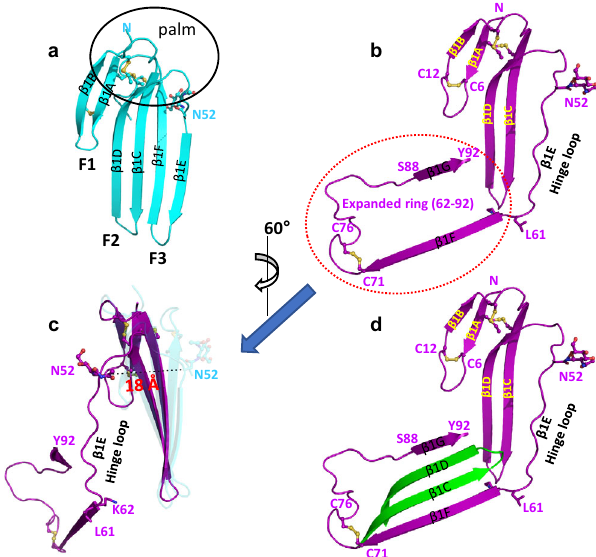
Fig. 3 Major conformational changes of the D1 of dimeric suPAR (this work) compared to the ligand-bound suPAR (PDB 3BT2). a D1 in the ligand-bound suPAR (cyan) forms a typical three- fi ngered fold with a palm region (circled) packed with highly conserved disul fi de bridges. The three fi ngers of this fold are labeled F1-F3. b In dimeric suPAR, the D1 of one protomer (magenta, in an orientation similar to in a ) has only two fi ngers with the β 1F strand of the third fi nger swings away from the D1 pivoting on a hinge (residue 60 – 62, black dashed circle) of D1. The β 1F strand, along with a long loop between the D1 and D2, forms a long expanded ring (residue 62 – 92, circled in the red dashed circle). c A 60°rotation along Y axis of the B orientation shows the β 1E in D1 of dimeric suPAR (magenta) dislodges away, in parallel, from the fi rst and the second fi ngers, leading to a shift of 18 Å, compared to the D1 of ligand-bound suPAR (shown in transparent cyan). d The expanded ring captures the β 1C- β 1D hairpin (green) of the other protomer of suPAR. Such interactions are the key for dimeric suPAR